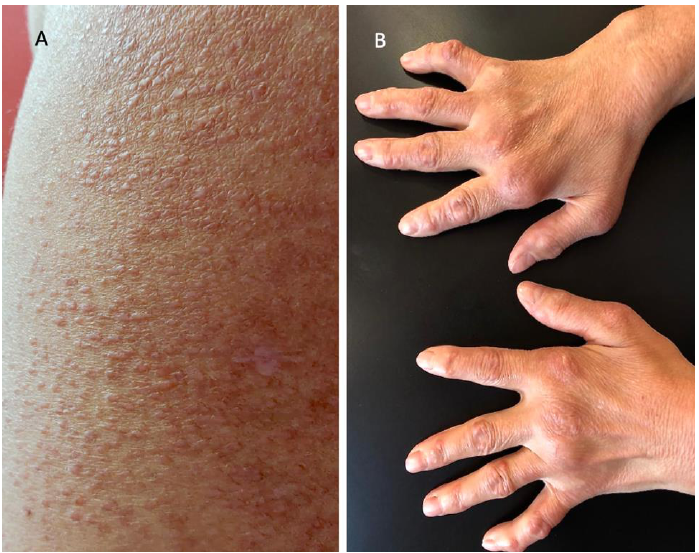
Figure 2. Detail of the lesions of the skin: ( A ) non-confluent papule of the upper body; ( B ) periungual and periarticular skin-colored nodules.